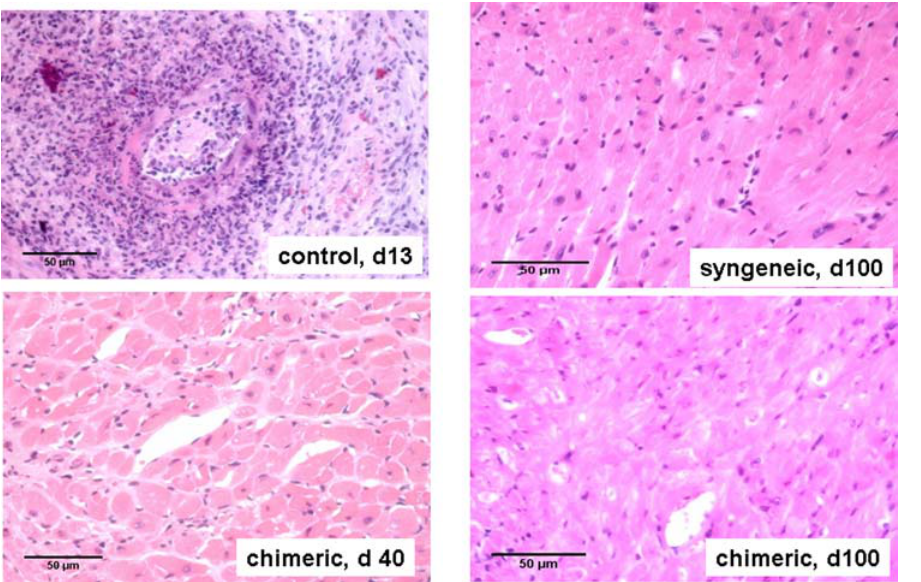
Figure 6. HPC-induced mixed chimerism preserves organ architecture post-transplantation. Transplanted syngeneic and allogenic animals were sacrificed at either 40 or 100 days post-transplantation and the histology of the grafts studied after H & E staining. These grafts showed preservation of the muscle architecture and lack of mononuclear cell infiltration in the syngeneic and tolerant grafts, but massive tissue destruction in the acutely rejected control grafts.